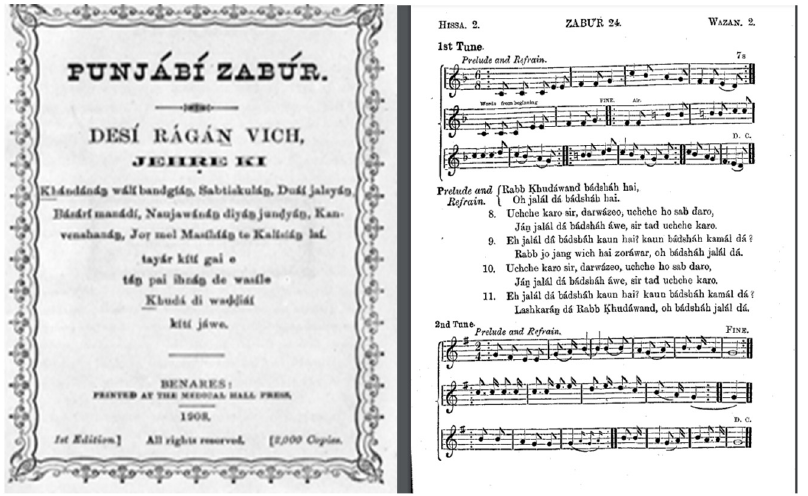
Figure 2. ( left ) Title page of the Punjabi Psalter 1908; ( right ) Text and tune of traditional Psalm 24:7–10.